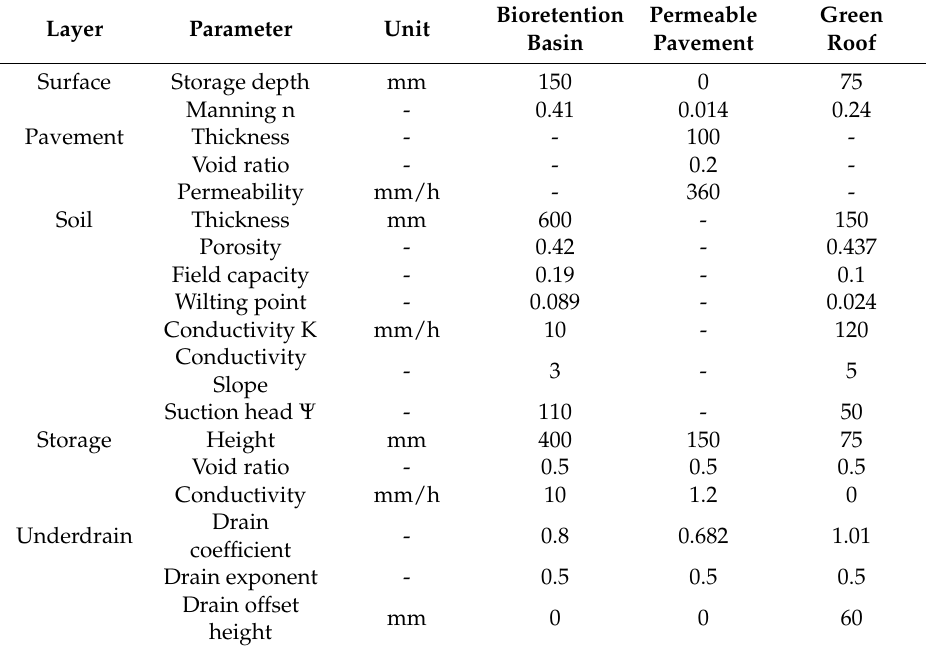
Table 2. The parameters of LID designs.